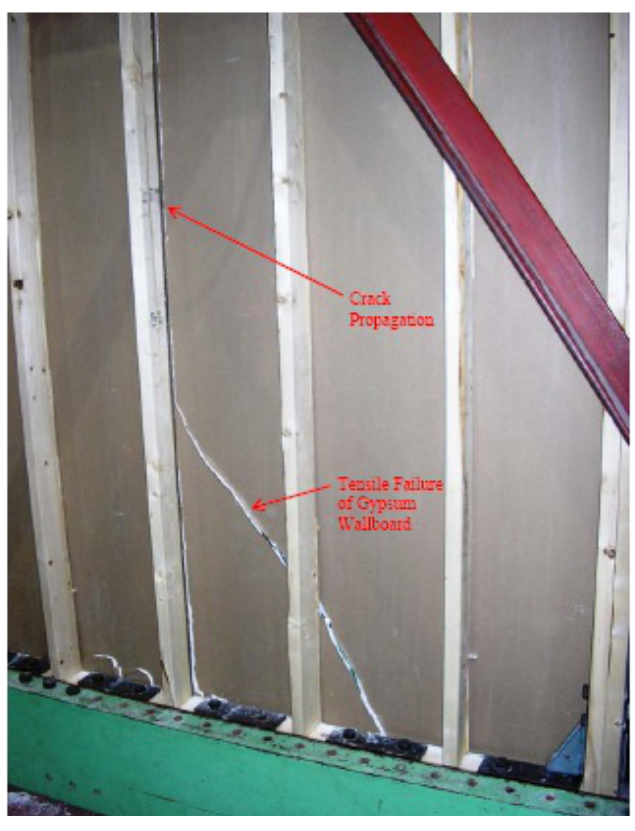
Figure 23. Damage to lower half of VEwall 3.